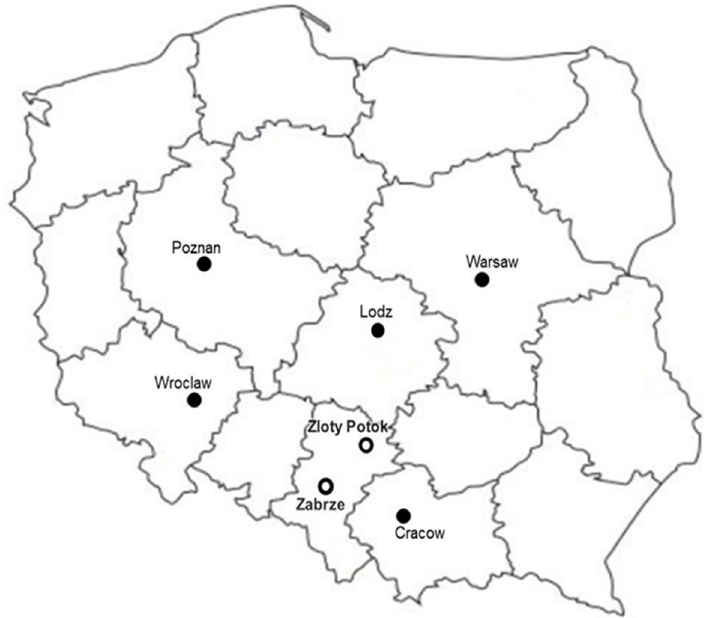
Figure 1. Locations of the air monitoring stations Zabrze and Złoty Potok in Poland.